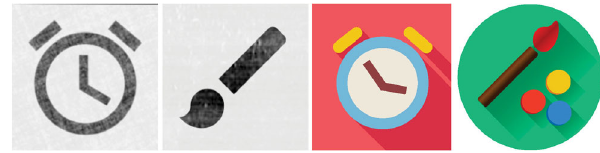
Fig. 7 Image editing on a rasterized image at a primitive level. Primitive detection is performed on the image, followed by editing of the primitives.